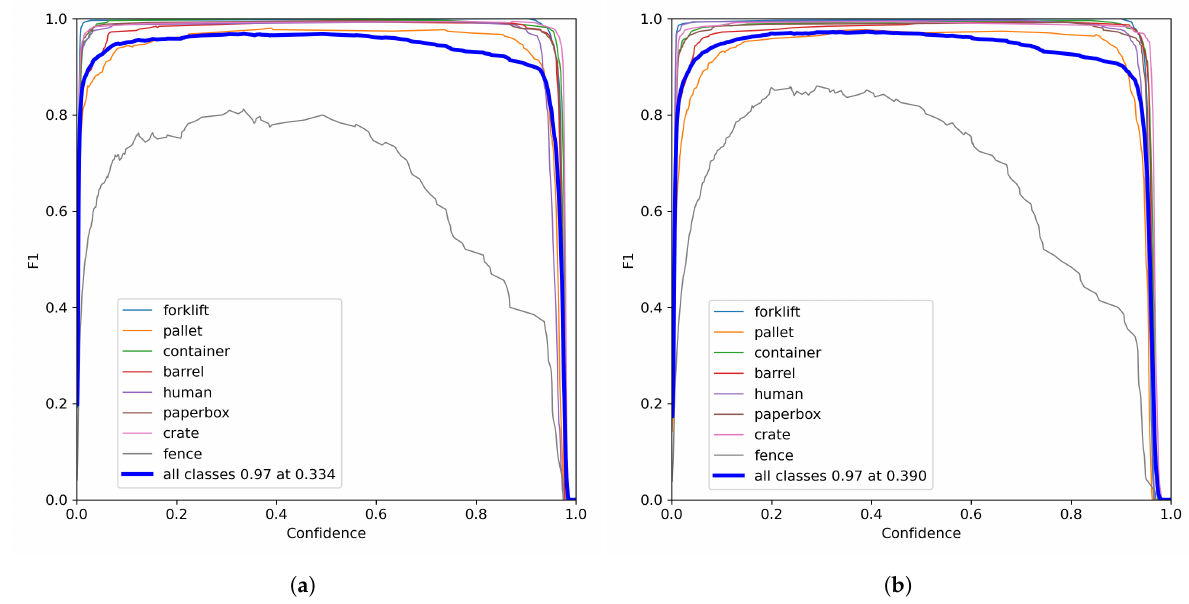
Figure 12. F 1 score comparison at various confidence values: ( a ) small model; ( b ) xlarge model. Comparing evaluation measurements between the small and the xlarge model in Figure 13 shows that the xlarge model provided better results than the small model.